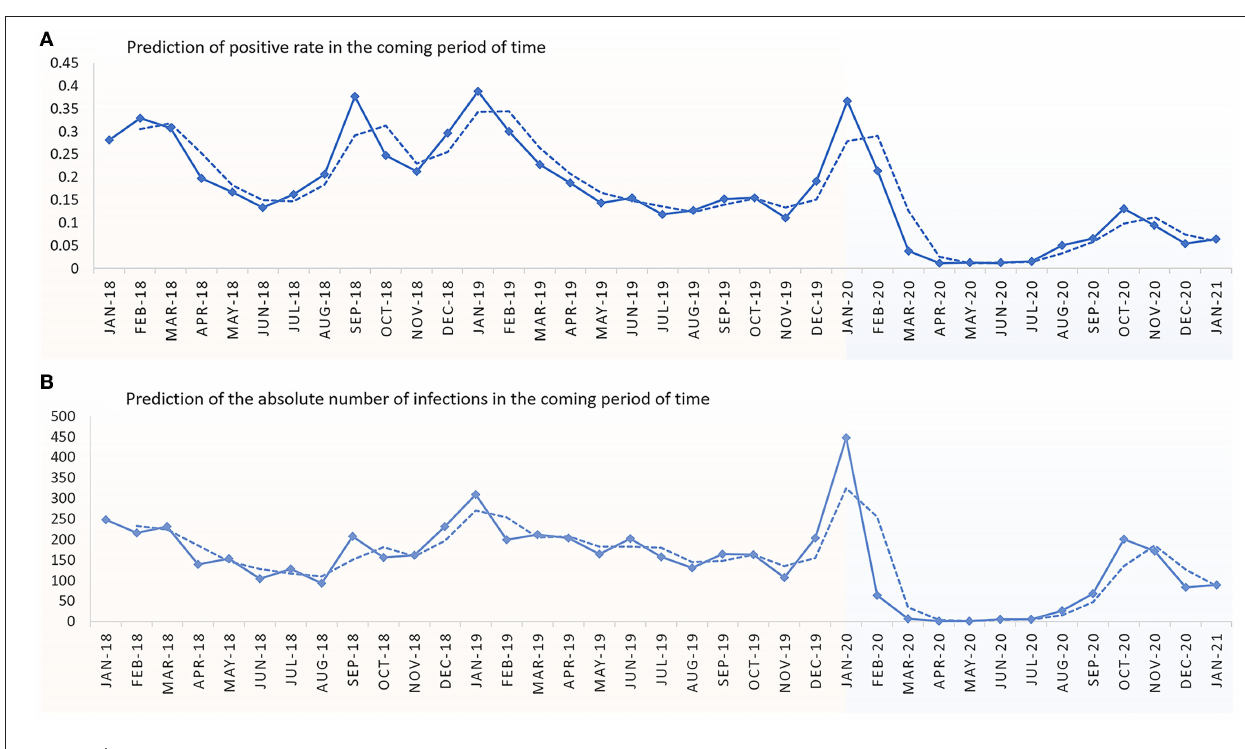
FIGURE 3 | Prediction of the absolute number of infections and the positive rate of children hospitalized in Xiamen Children’s Hospital in the next months of 2021. (A) Prediction of positive rate in the coming period of time. (B) Prediction of absolute number of infections in the coming period of